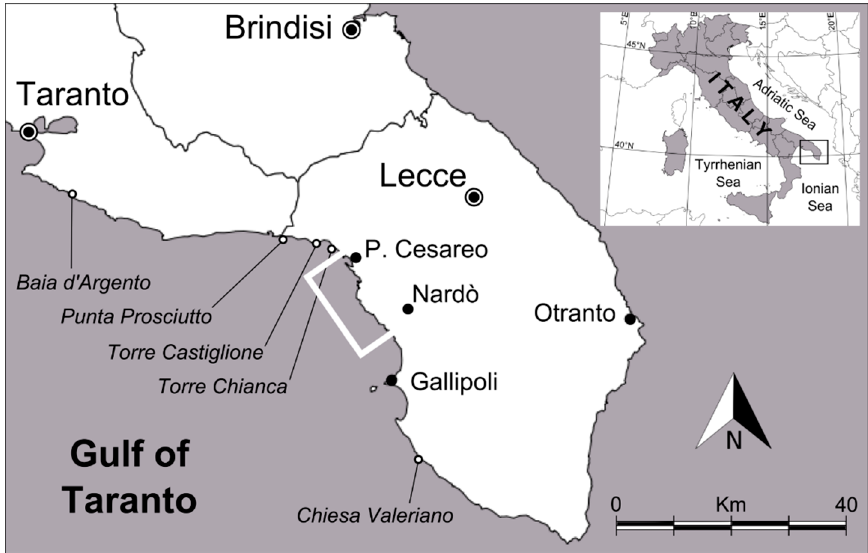
Figure 2. Geographical position of the studied area and main localities cited in the text.